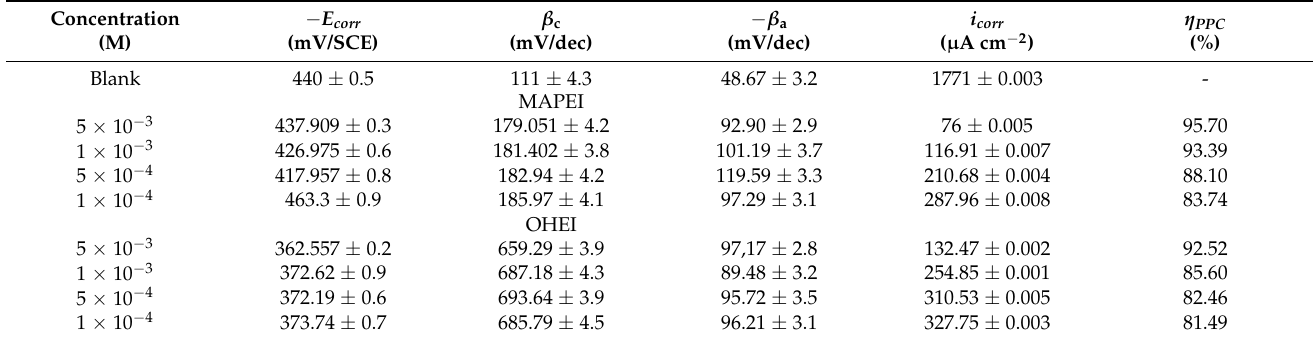
Figure 3. Potentiodynamic polarization curves of N80 steel in 15 wt.% HCl solution in the presence and absence of various concentrations of MAPEI and OHEI at 303 K. Table 3. Electrochemical parameter values estimated from potentiodynamic polarization curves of N80 steel in 15 wt.% HCl solution without and with various concentrations of MAPEI and OHEI at 303